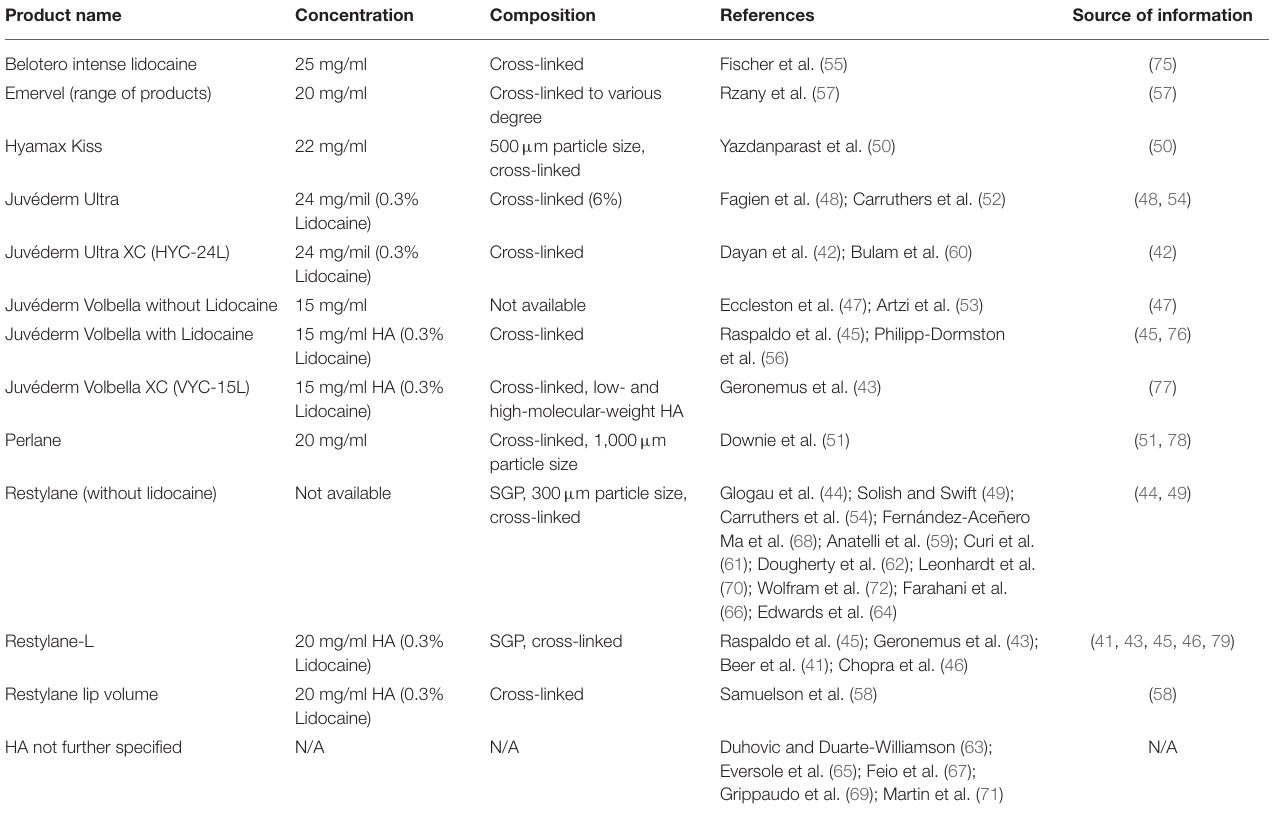
TABLE 3 | Characteristics of hyaluronic acid dermal fillers assessed in the